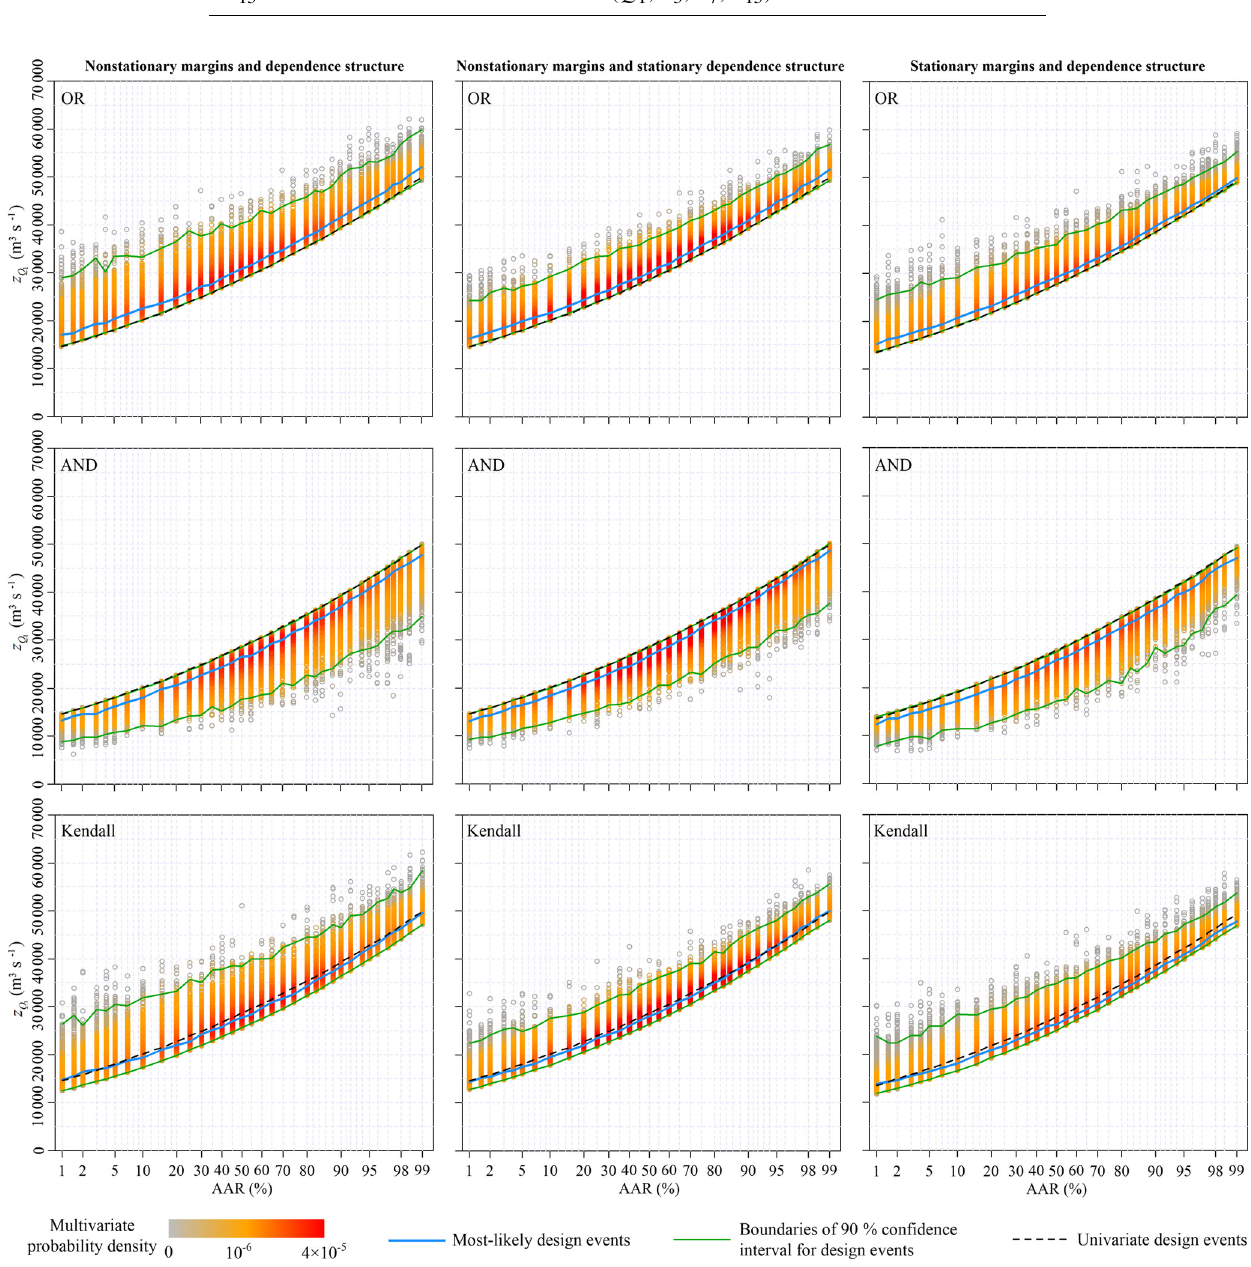
Figure 7. Design values of the annual maximum daily discharge for different average annual reliability (AAR) varying from 0.01 to 0.99 under three nonstationary